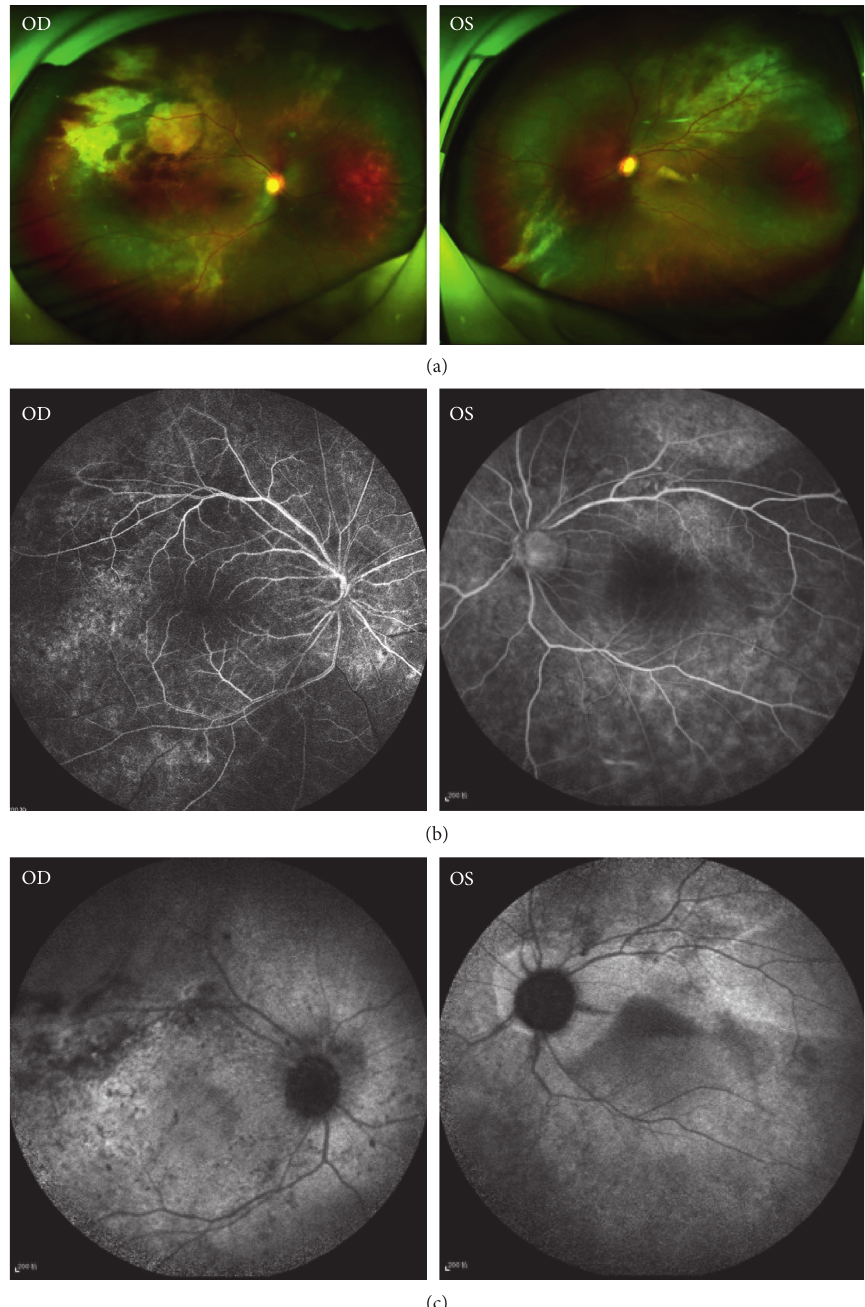
Figure 2: Images of the ocular fundus. (a) SLO showed revealed extensive subretinal hyper-reflective foci in superior-temporal region bilaterally, and exudative retinal detachment was observed in the inferior-temporal region of the retina in SLO in the right eye. (b) FFA showed relatively weak background fluorescence and diffuse mottled RPE, while changes in retinal vasculature were unremarkable. (c) ICGA photography showed diffuse hypofluorescence, revealing the extensive loss of choroidal